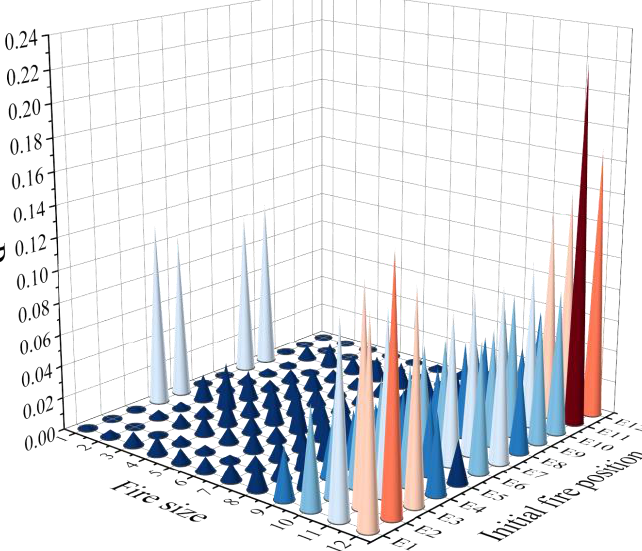
Figure 7. The result of fire size probability of occurrence caused by the initial fire position for each equipment